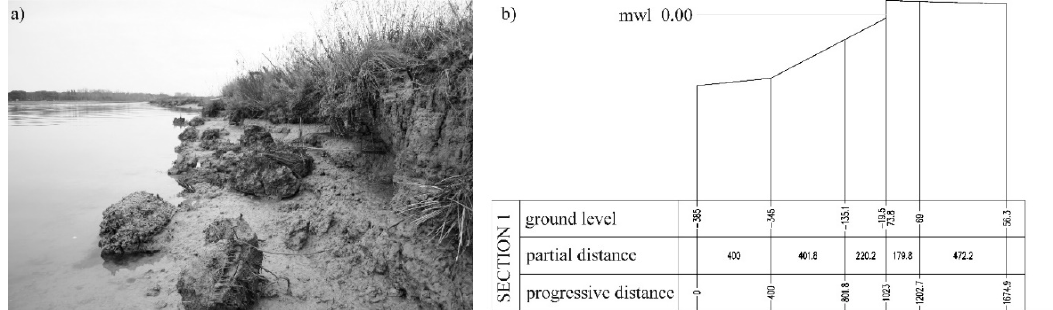
Figure 10. The right-hand side bank: ( a ) a picture after a flood event, in low-tide conditions where an upper vertical side and a lower less steep slope are well recognizable as well as failed bocks of material; and ( b ) a survey of the bank.